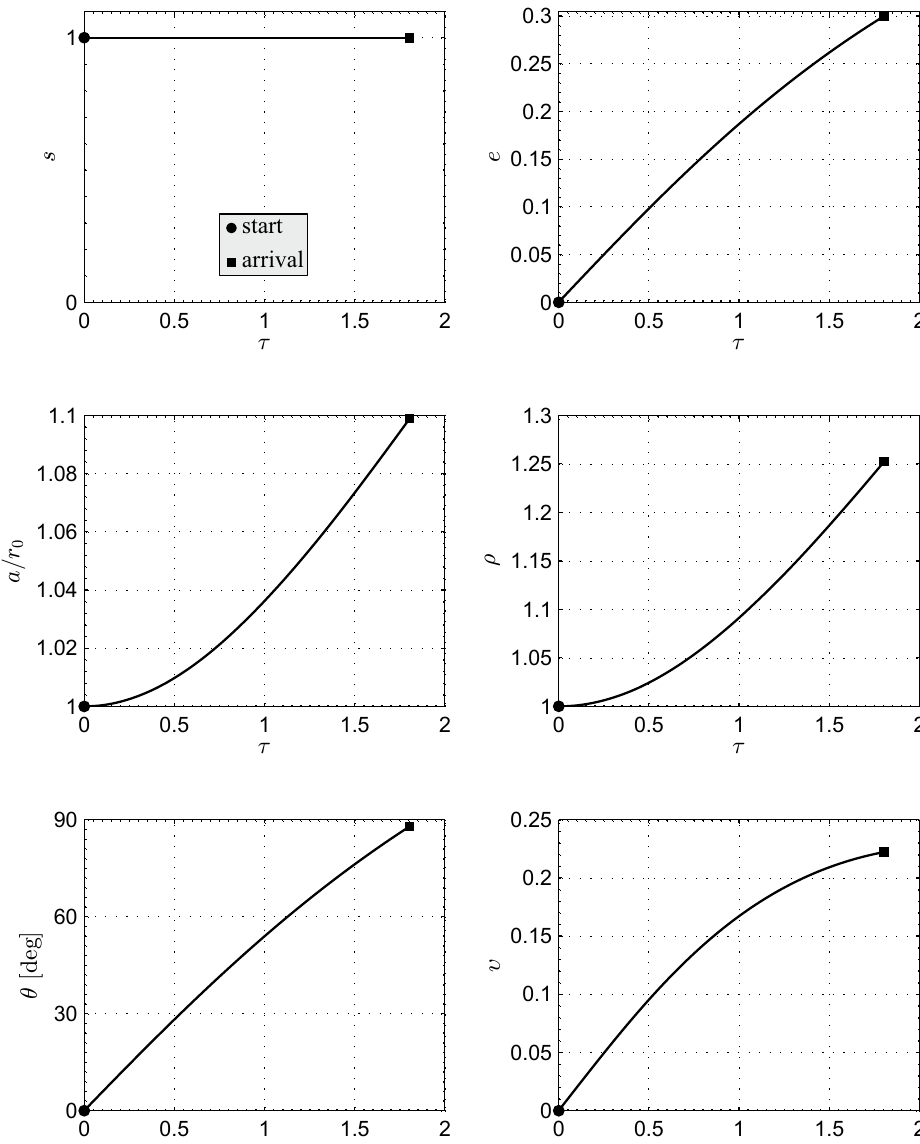
Figure 6. Optimal τ -variation of the spacecraft states when e f = 0.3 and β = 0.2.